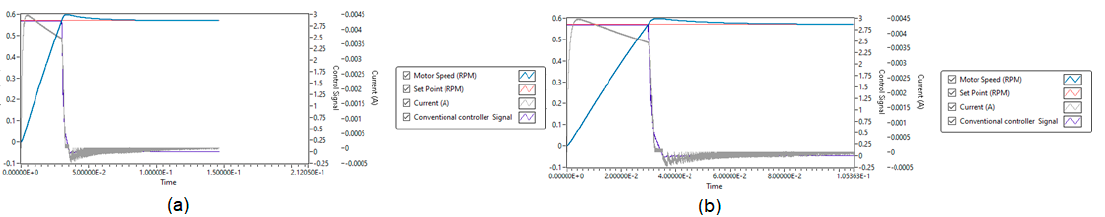
Figure 6. Robust controller ( a ) and conventional PID controller ( b ) dynamic response when reference speed is 0.57 P.U., and the DC motor parameters (armature inductance L and armature resistance R ) are changing 100%, time in seconds.